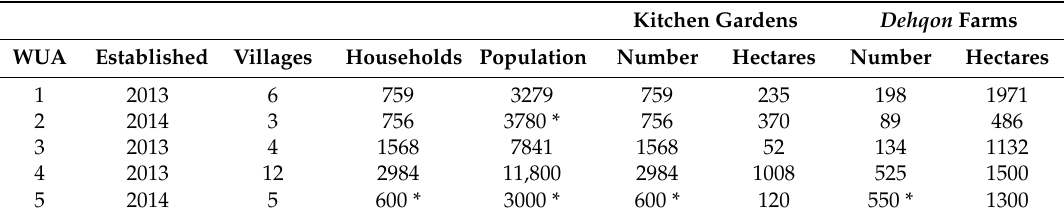
Table 1. Water User Association (WUA)